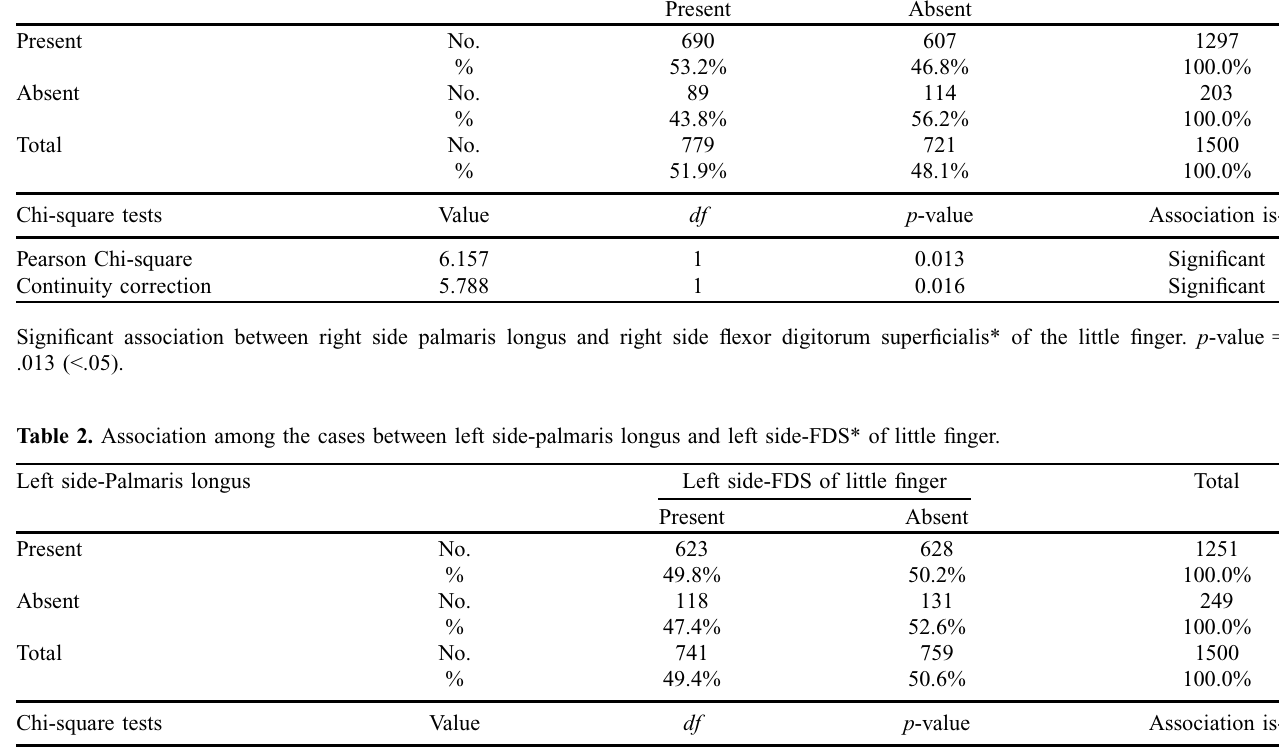
Table 1. Association among the cases between right side-palmaris longus and right side-FDS* of little finger. Right side-Palmaris longus Present